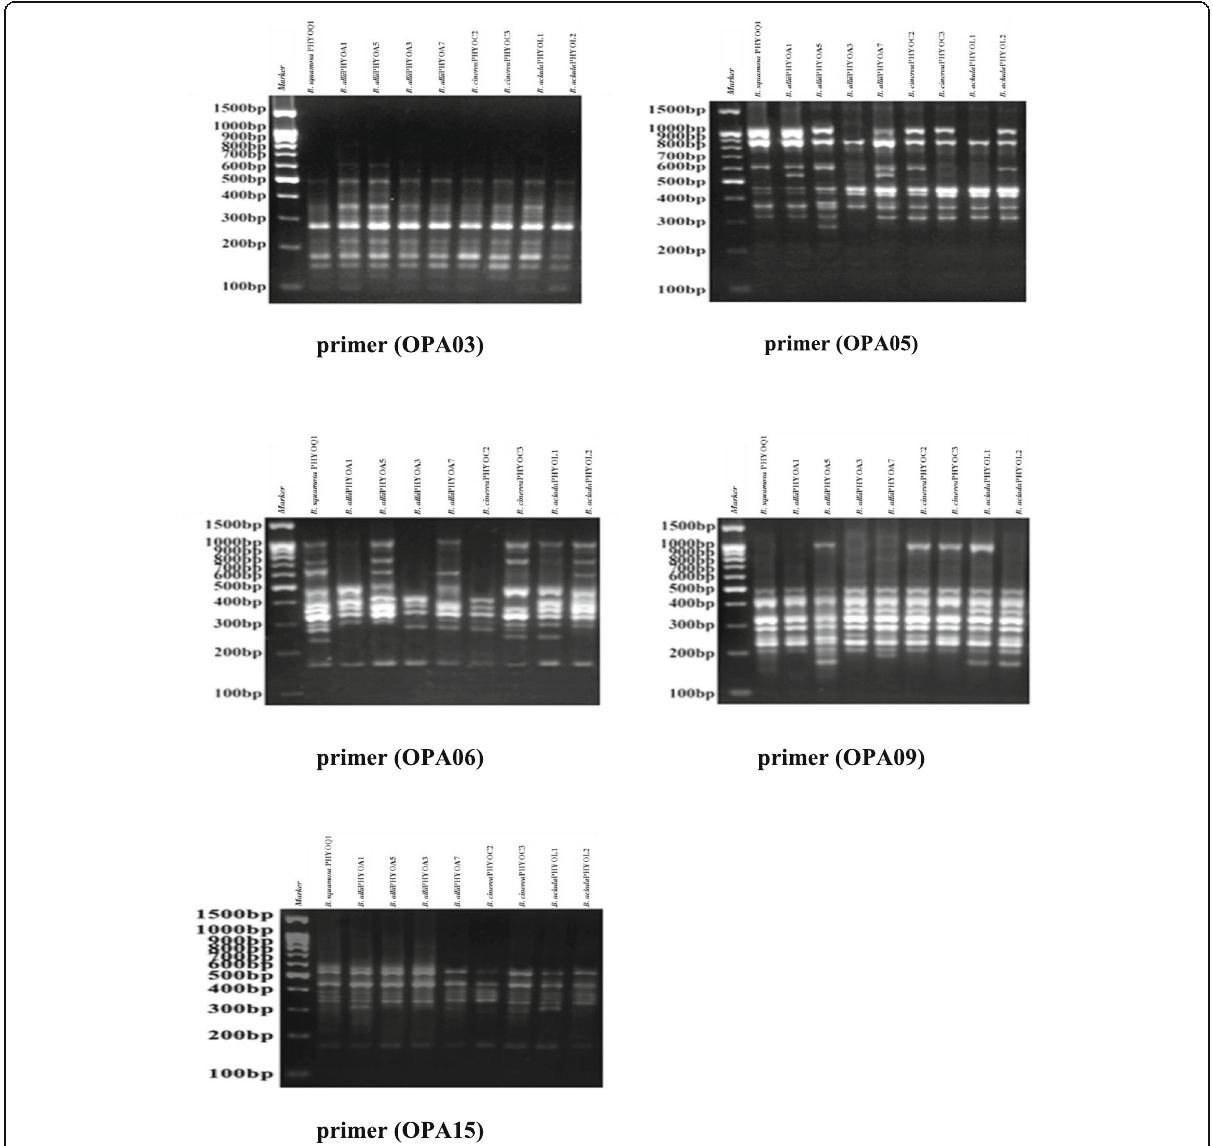
Fig. 2 Agarose gel electrophoresis of RAPD-PCR primers OPA03, OPA05, OPA06, OPI09 and OPW15 profile of nine Botrytis spp.